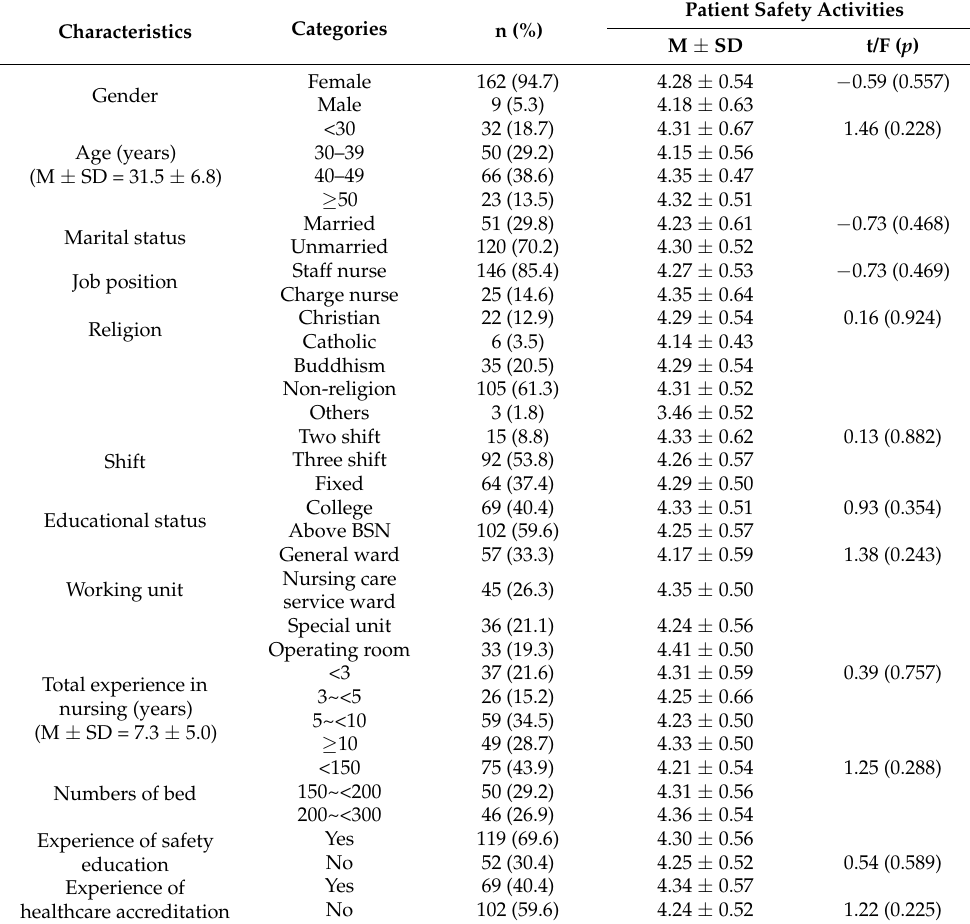
Table 1. Patient Safety Activities according to Characteristics (N =